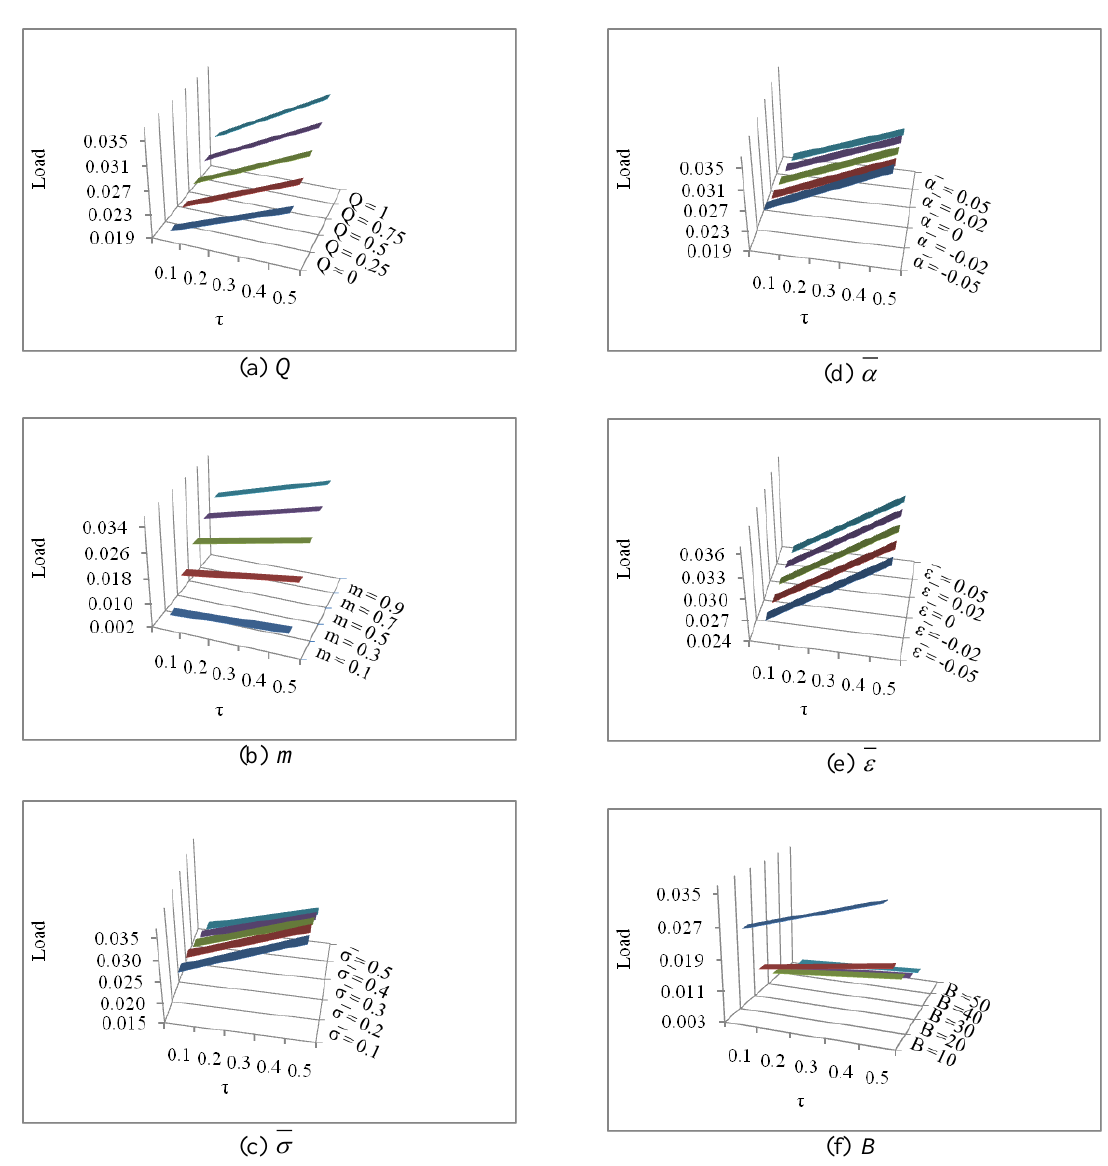
Figure 2. Profile of load bearing capacity with regards to